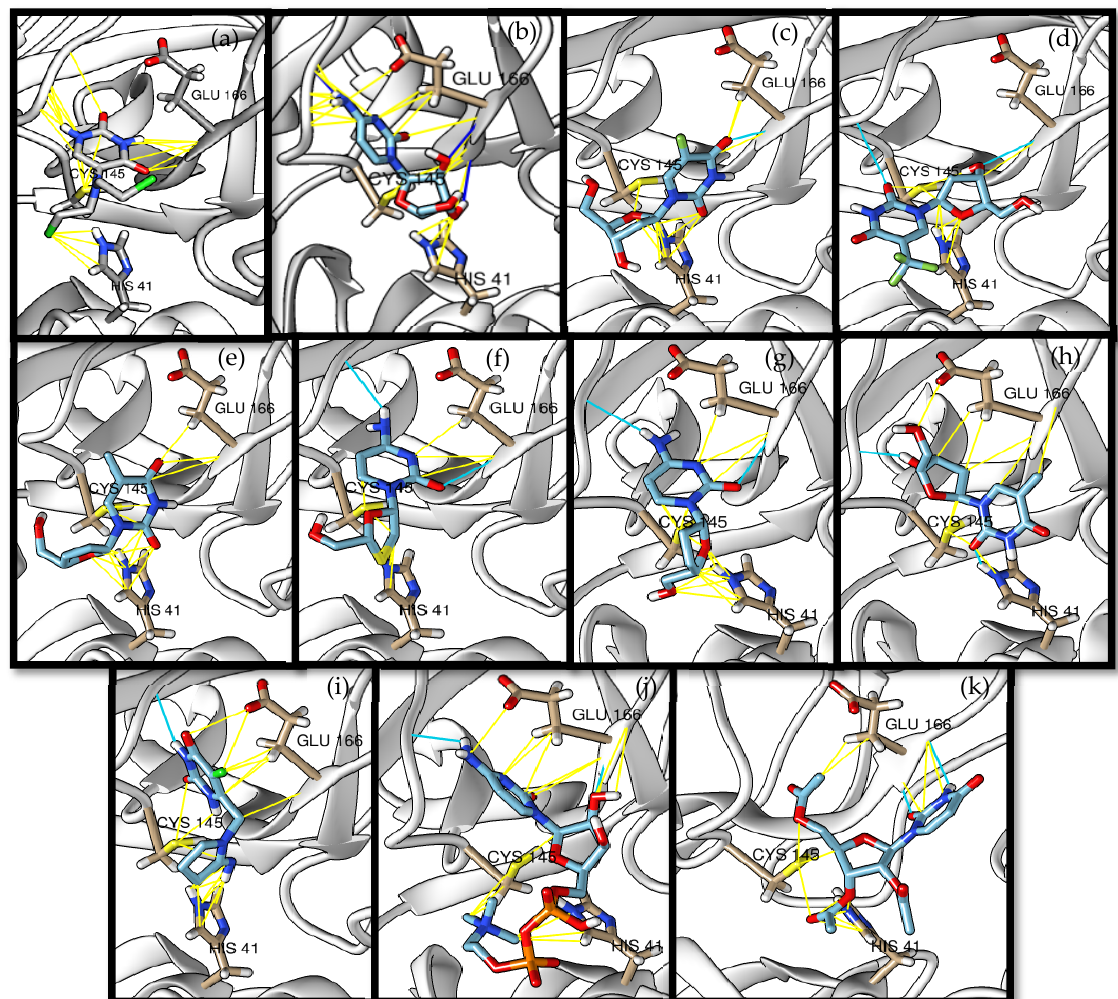
Figure 2. The PPs docked with 3CL pro , focusing on contacts with HIS 41, CYS 145, and GLU 166. ( a ) uracil mustard, ( b ) cytarabine, ( c ) floxuridine, ( d ) trifluridine, ( e ) stavudine, ( f ) lamivudine, ( g ) zalcitabine, ( h ) telbivudine, ( i ) tipiracil, ( j ) citicoline, ( k ) uridine triacetate. The hydrocarbon skeleton is shown in cyan, nitrogen atoms are blue, and oxygens are red. Hydrogen bonds are represented by blue lines; van der Waals forces are represented in yellow.